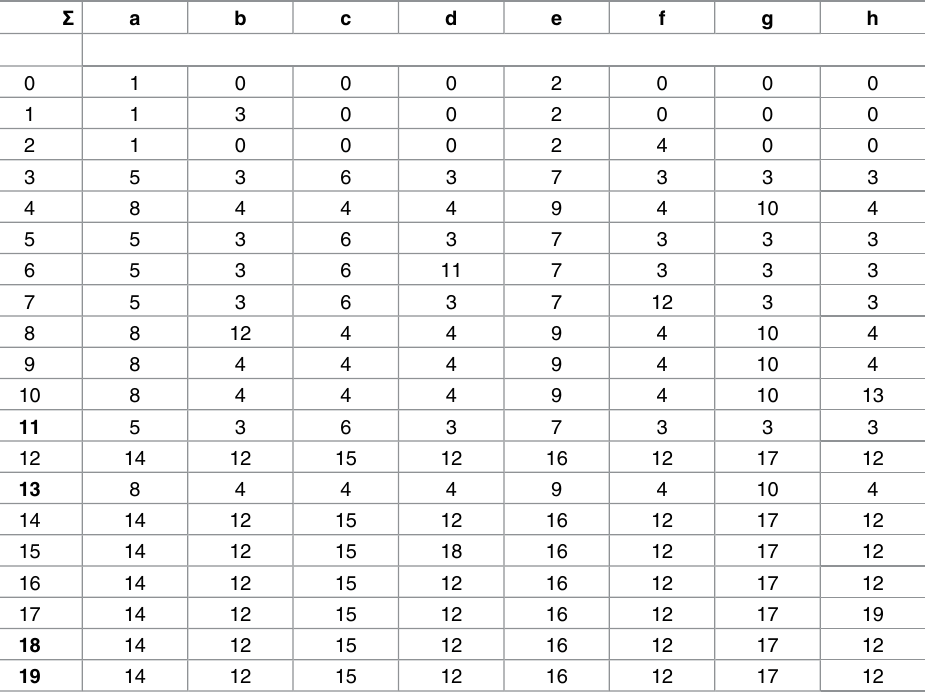
Table 1. State transition table for regular expressions (ab. * cd, ef. *